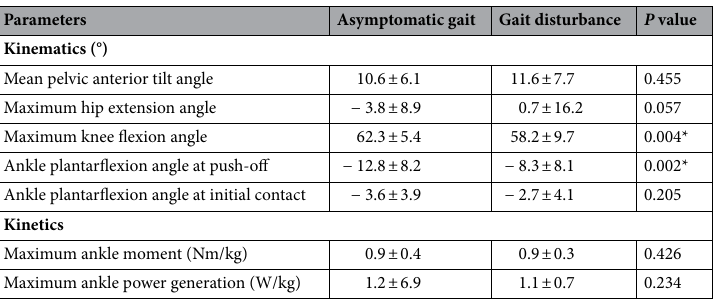
Maximum ankle power generation Table 4. Comparison of postoperative kinetic and kinematic parameters between groups. Negative values indicate hip extension and ankle plantarflexion. * P < 0.05.